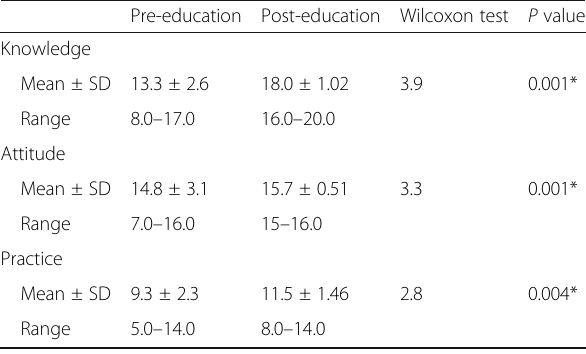
Table 2 Knowledge, attitude, and practice of nurses regarding antimicrobial stewardship before and after educational